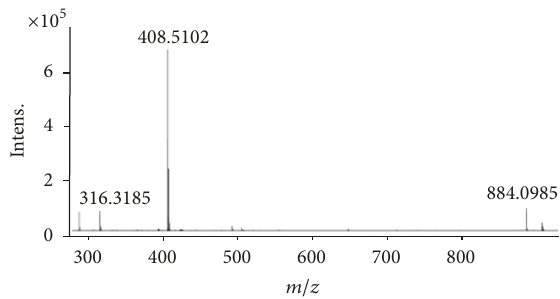
Table 3: Hydrogen bonds for H 2 L 2